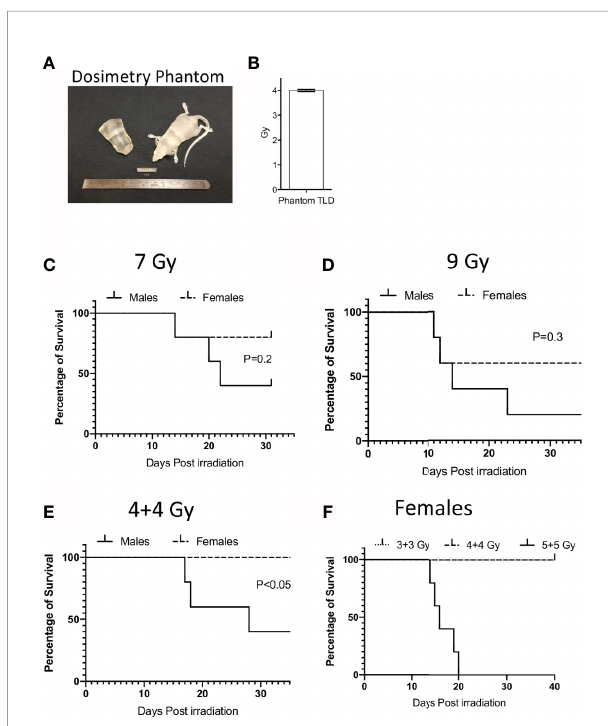
FIGURE 1 | Dosimetry and IR induced lethality in male and female Balb/c mice. (A) Murine morphic phantom of 25g mouse/torso and 1x1x1 mm thermoluminescent dosimeters (TLD) cubes (white) are shown. TLDs can be placed within the mouse to con fi rm the delivered dose. (B) TLD measurements were shown to de fi ne the dosimetry of 4 gy IR from varian linac. Male or Female animals (n=5 per group) were subjected to single dose (C) 7Gy, (D) 9Gy or split dose irradiation with 4-hour intervals (E) (4 + 4 Gy). Kaplan Meier survival curves were plotted between male and female animal groups. (F) Dose dependent split dose irradiation was tested in